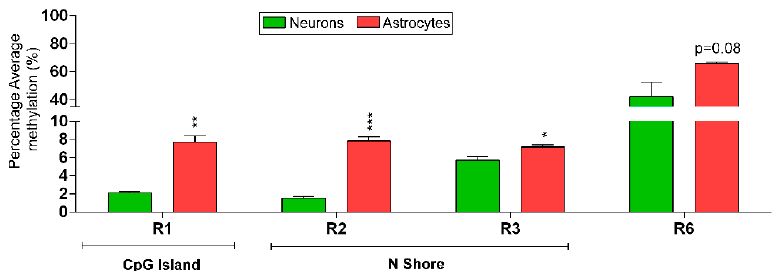
Figure 4. Average DNA methylation patterns over the Mecp2 regulatory elements (REs) in male neurons and male astrocytes. Average percentage DNA methylation of all CpG sites in the promoter regions R1 (13 CpGs), R2 (4 CpGs), R3 (2 CpGs), and R6 of the intron 1 region (2 CpGs), in male neurons and male astrocytes. Significant difference between male neurons and male astrocytes is indicated with *** p < 0.001, ** p < 0.01, or * p < 0.05. N = 3. Error bars indicate standard error of the mean (SEM).